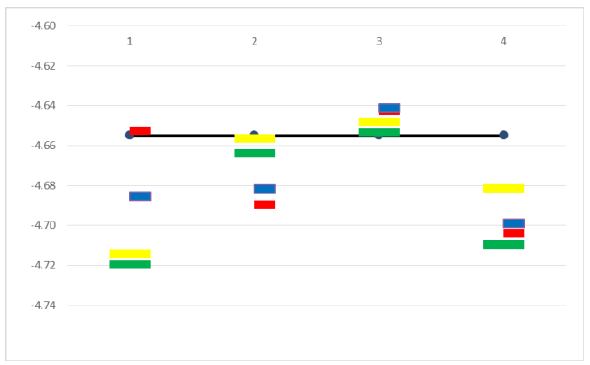
Figure 12. Ceiling of first level.